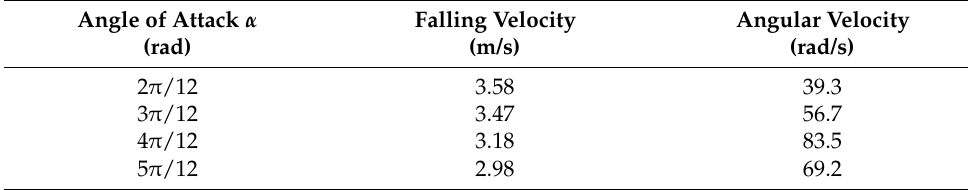
Table 1. Falling velocity with respect to angle of attack and angular velocity.